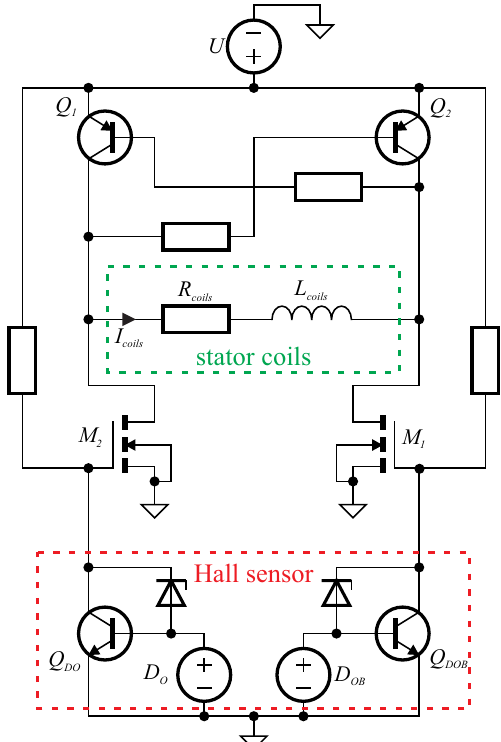
Figure 4. Schematic of coil current control circuit, with Hall sensor IC (given as schematic principle) switching two metal-oxide-semiconductor field-effect transistors (MOSFETs) M 1 and M 2 enabling current I coils to flow in one or the other direction from driving PNP transistors Q 2 and Q 1 through the stator